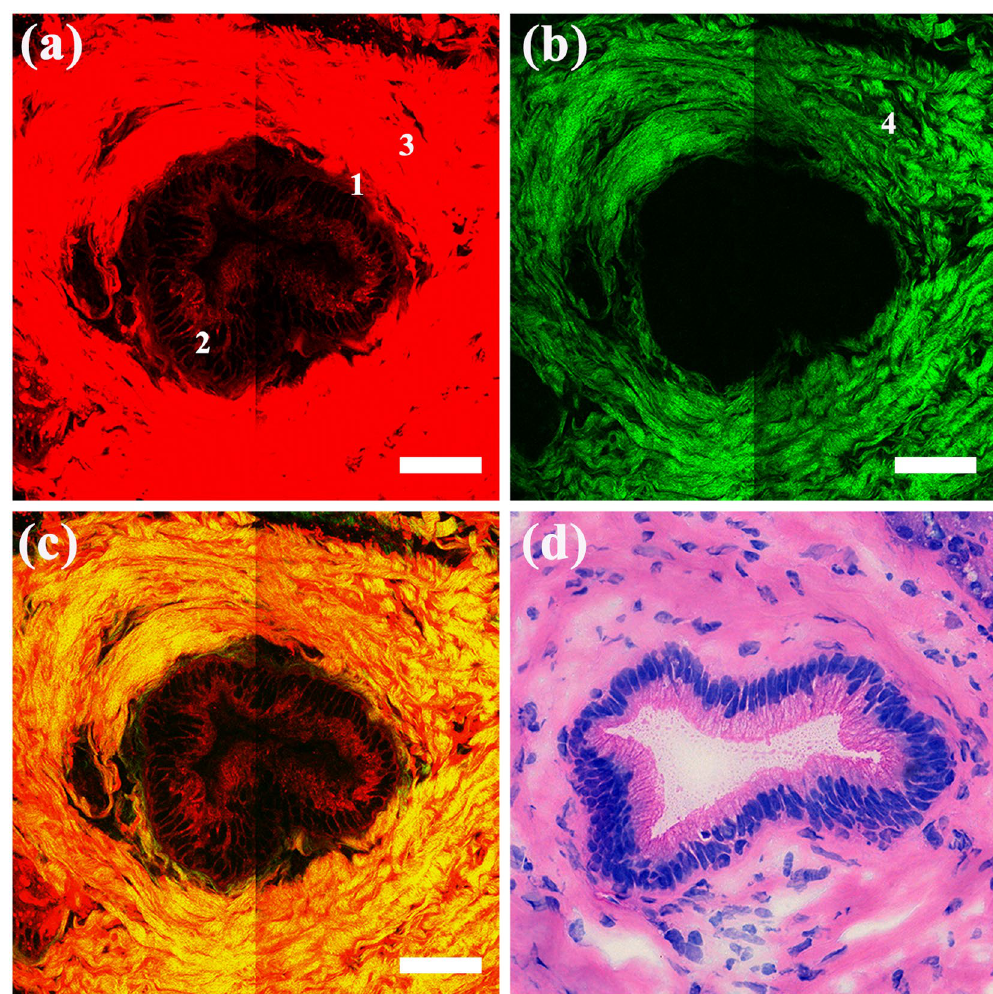
Figure 1. MPM images and the corresponding H&E-stained images of a normal pancreatic duct. Magnification of H&E-stained image is 40 × ; Scale: 50 μ m. ( a ) TPEF image; ( b ) SHG image; ( c ) Overlay of TPEF and SHG image; ( d ) H&E-stained image. Position 1: single layer of columnar cells; position 2: multilayer structure of duct cells; position 3: collagen detected by TPEF signal; position 4: collagen detected by SHG